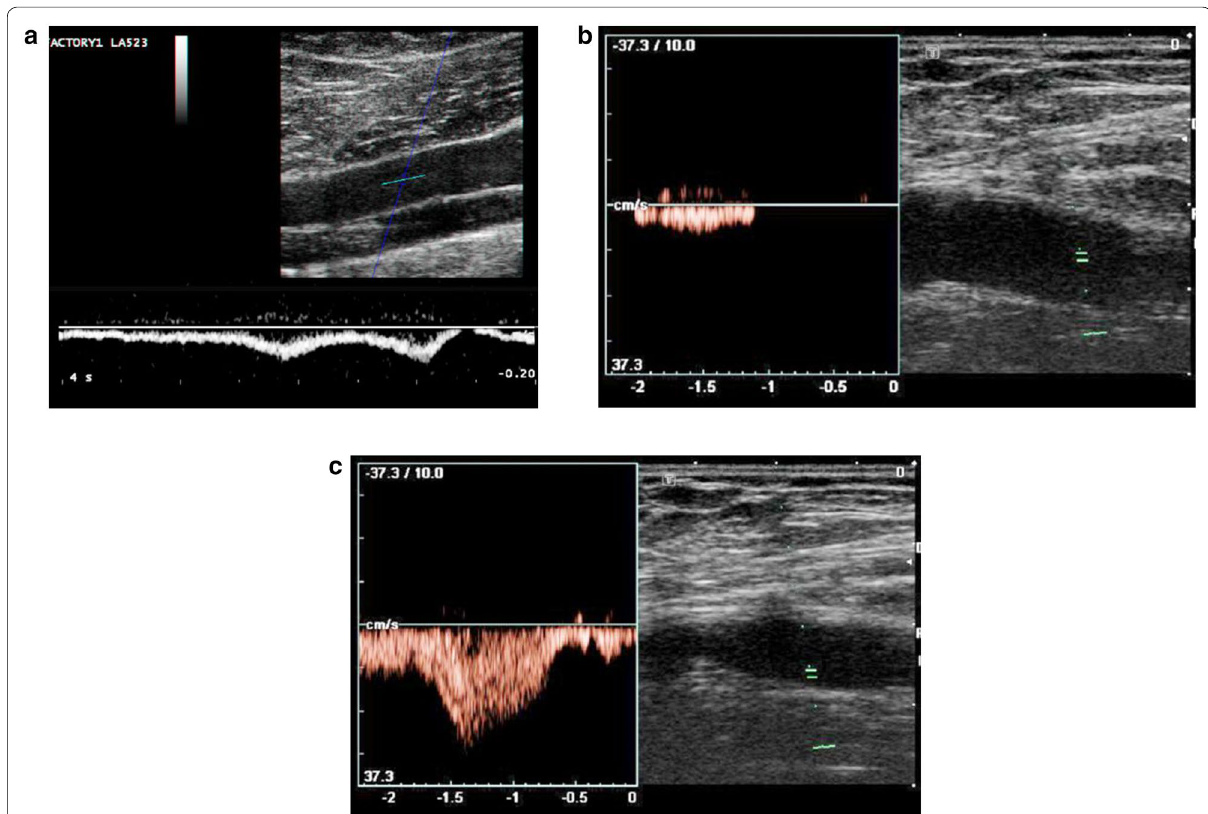
Fig. 8 Normal spectral Doppler venous flow. a respiratory variability, b a proximal compression or a Valsalva maneuver cause stop of the flow, c the distal compression of the vein cause an increase of the velocity of the flow (augmentation)